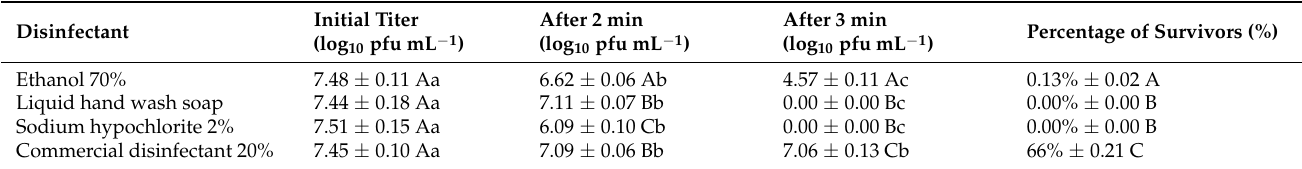
Table 6. Effects of chemical disinfectants on the phage UAE_MI-01.